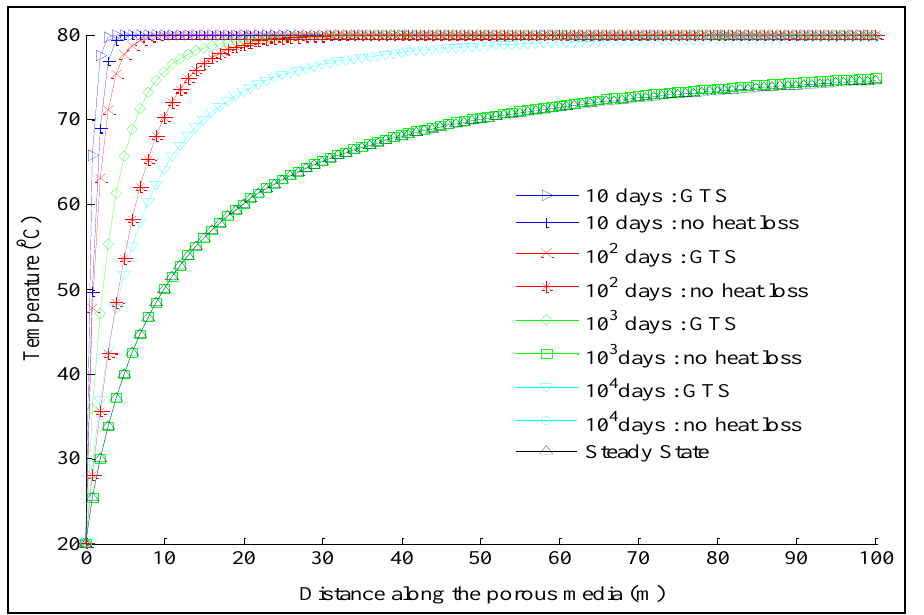
Figure 3. Temperature distribution plots in the geothermal aquifer at different injection times for the general transient solution and the no heat loss case.